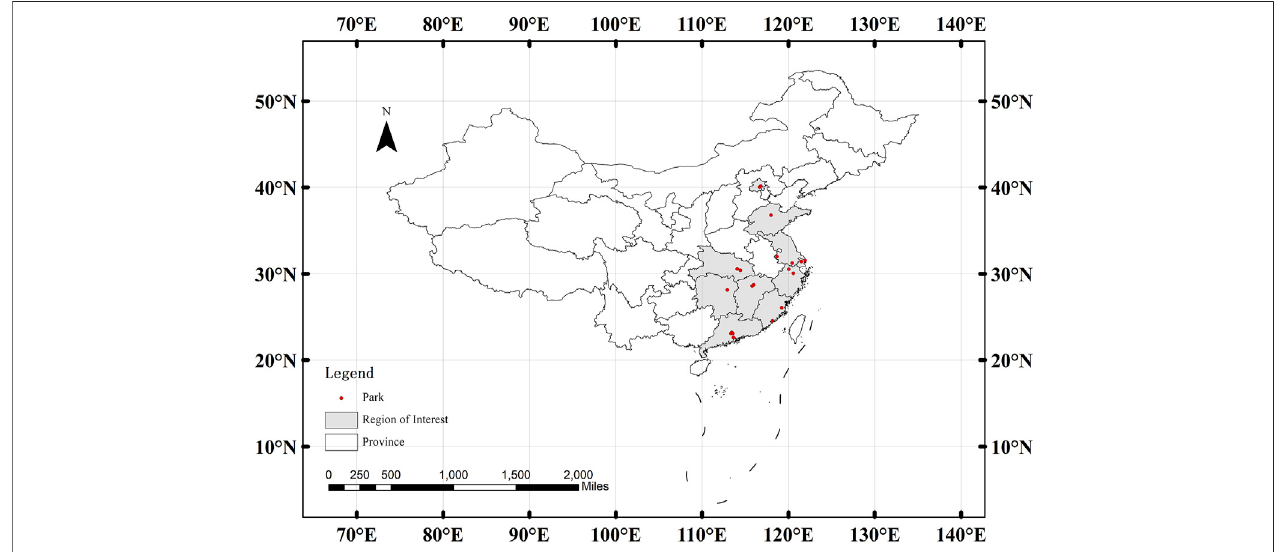
FIGURE 1 | Distribution of urban wetland parks along the eastern coast of mainland China. Red spots mark locations of wetland parks. Regions in light gray are provincial areas where objective wetlands are located.